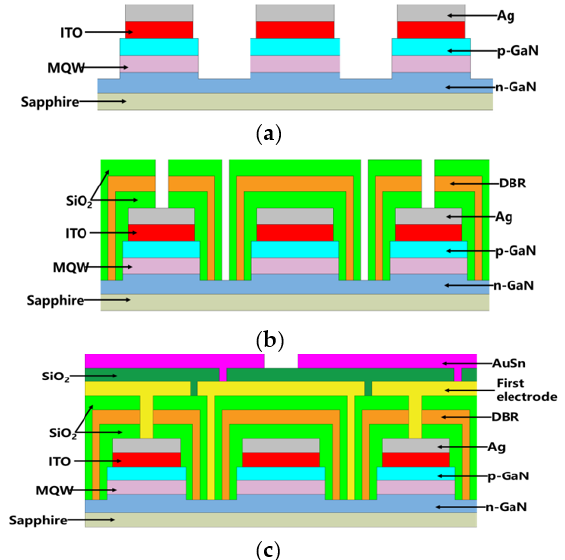
Figure 1. Main fabrication process of the CRS-FCLED. ( a ) a layer of Ag (120 nm) is sputtered on top of the ITO that acts as the reflecting lay-er; ( b ) the p-GaN contact orifices and n-GaN contact orifices were fabricated by ICP etching with a CF4/O2 gas mixture as the etching gas source; ( c ) an AuSn alloy solder layer was deposited by thermal evaporation.3. Results and